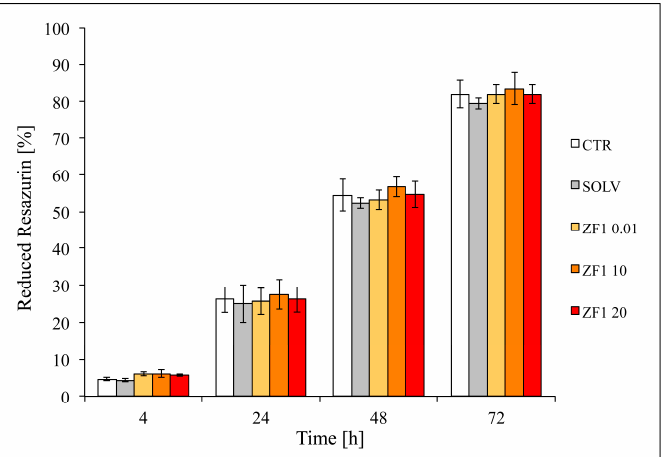
Figure 3. E ff ects of di ff erent concentrations of ZF1 on metabolic activity in hASCs. The percentage of resazurin reduction (as an indicator of cell proliferation) in hASCs treated with ZF1 (0.01, 10, and 20 µ g / mL) or a solvent (SOLV) or untreated (CTR). An analysis was conducted at 4, 24, 48, and 72 h from the beginning of the treatment and an experiment was performed in technical quadruplicate. Statistical significance was evaluated using ANOVA followed by the Tukey HSD test. Data are expressed as mean ± standard deviation (SD), n =